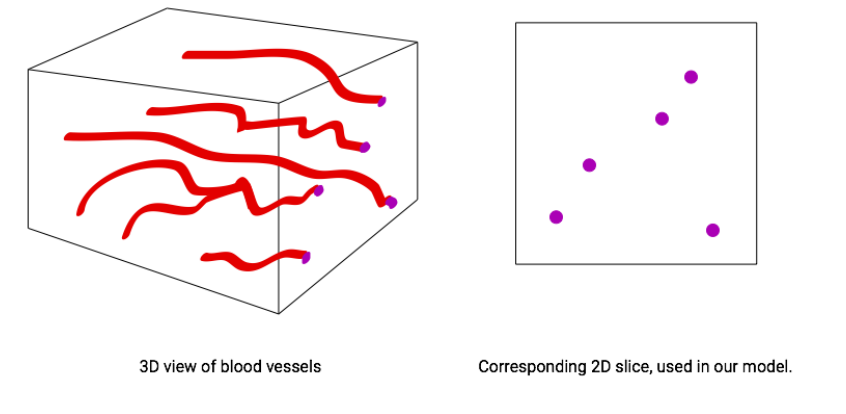
Figure 2. Cancer cells and blood vessels in a 3D space ( left ); and its 2D cross-section ( right